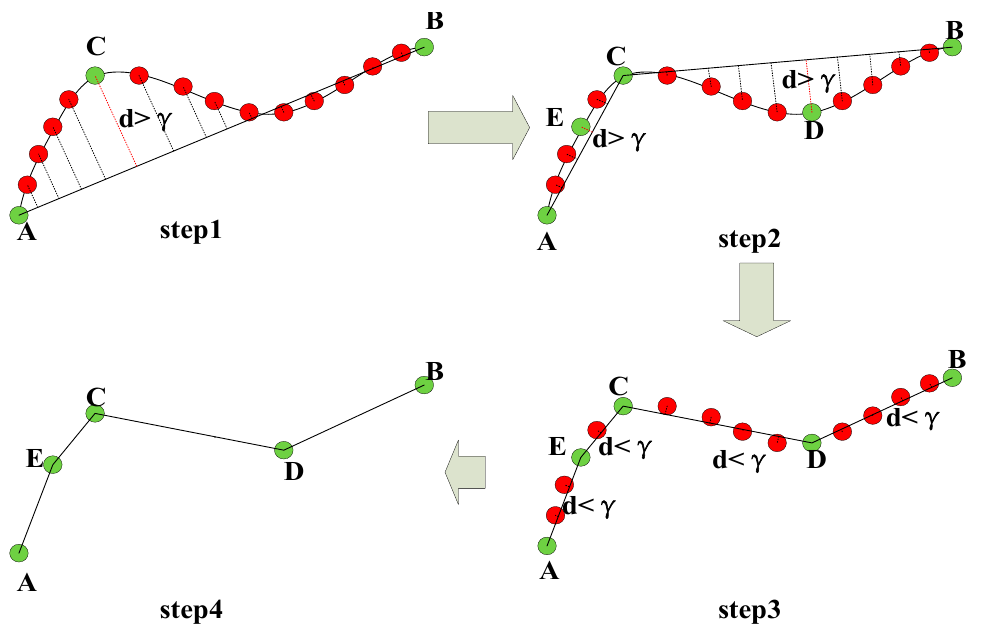
Figure 4. Schematic of the proposed Douglas–Peucker algorithm.